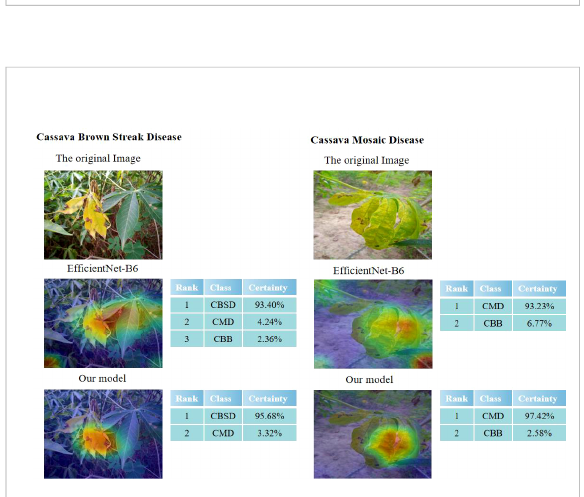
FIGURE 13 Confusion matrix for the test set.